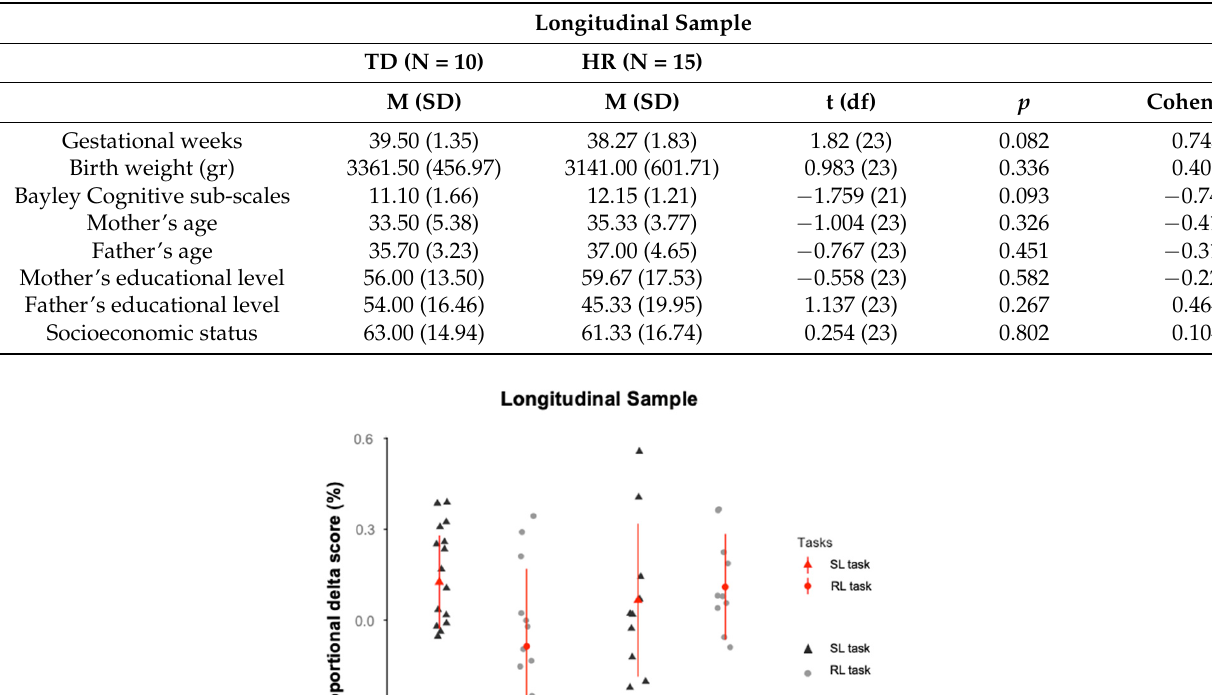
on all considered variables.